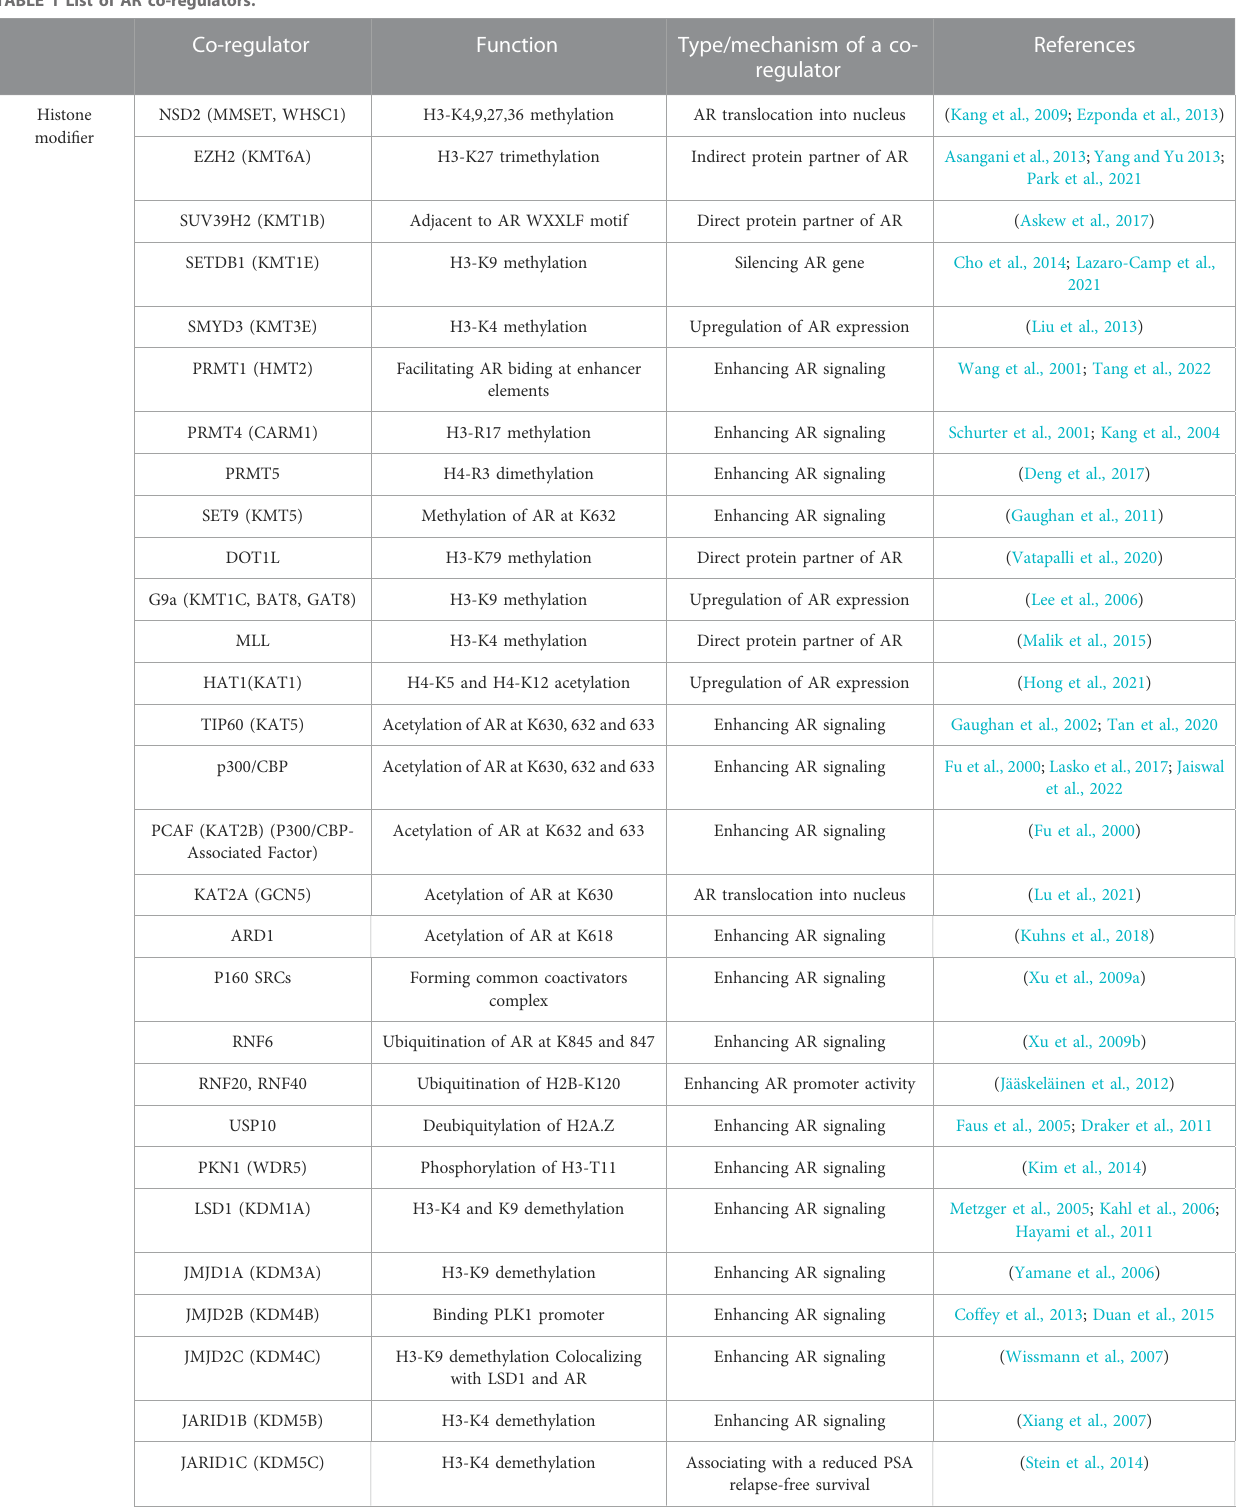
TABLE 1 List of AR